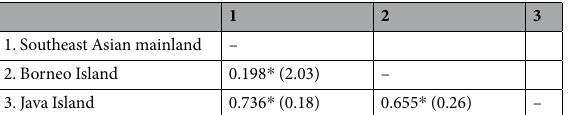
Table 2. Genetic differentiation, F ST and gene flow, Nm (in brackets) among Haematobia exigua in the Southeast Asian mainland, Borneo Island and Java Island. * P < 0.001.